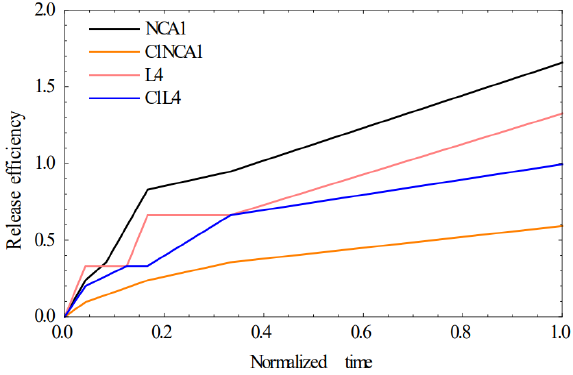
Figure 1. Drug permeation profiles across the Strat ‐ M ® artificial membrane .